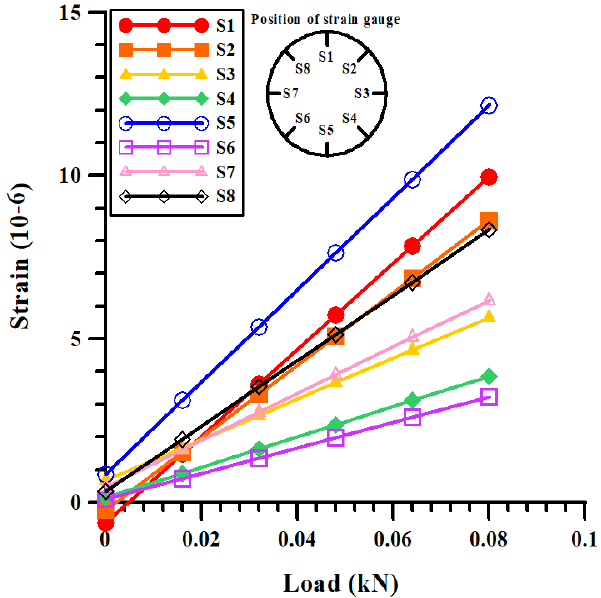
Figure 9. Results of model tunnel strain gauge calibration.